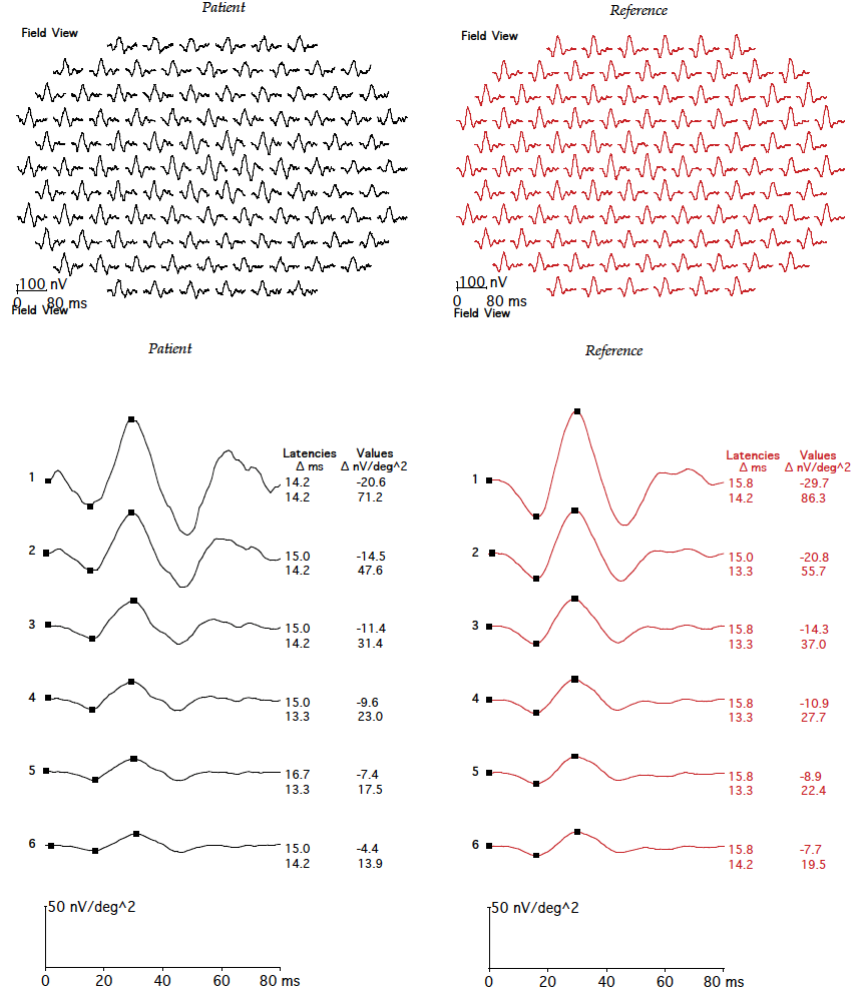
Figure 5: Multifocal ERG (trace array) reveals preserved macular function in the right eye.